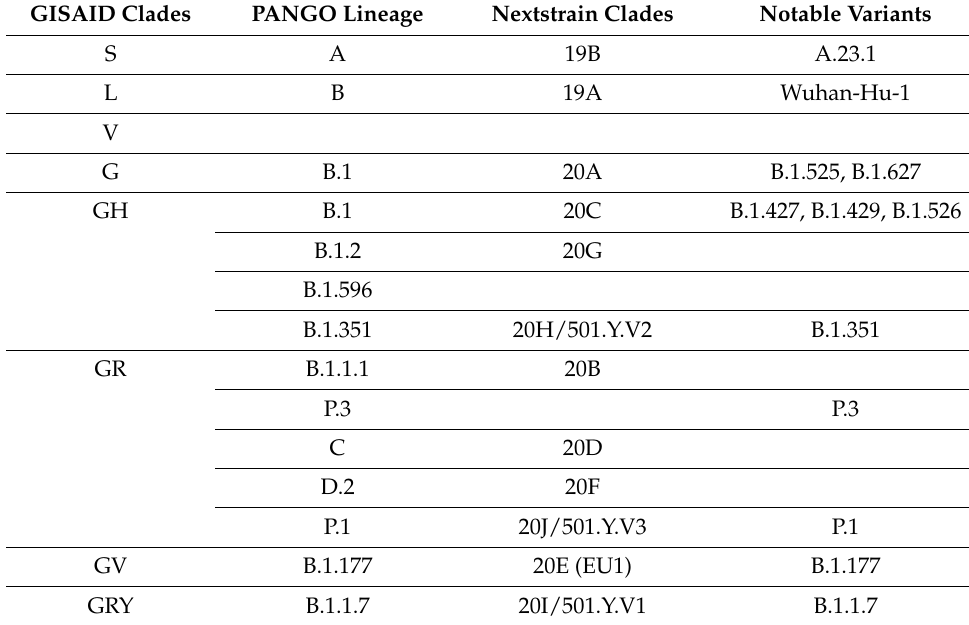
Table 1. Nomenclature of SARS-CoV-2. GISAID